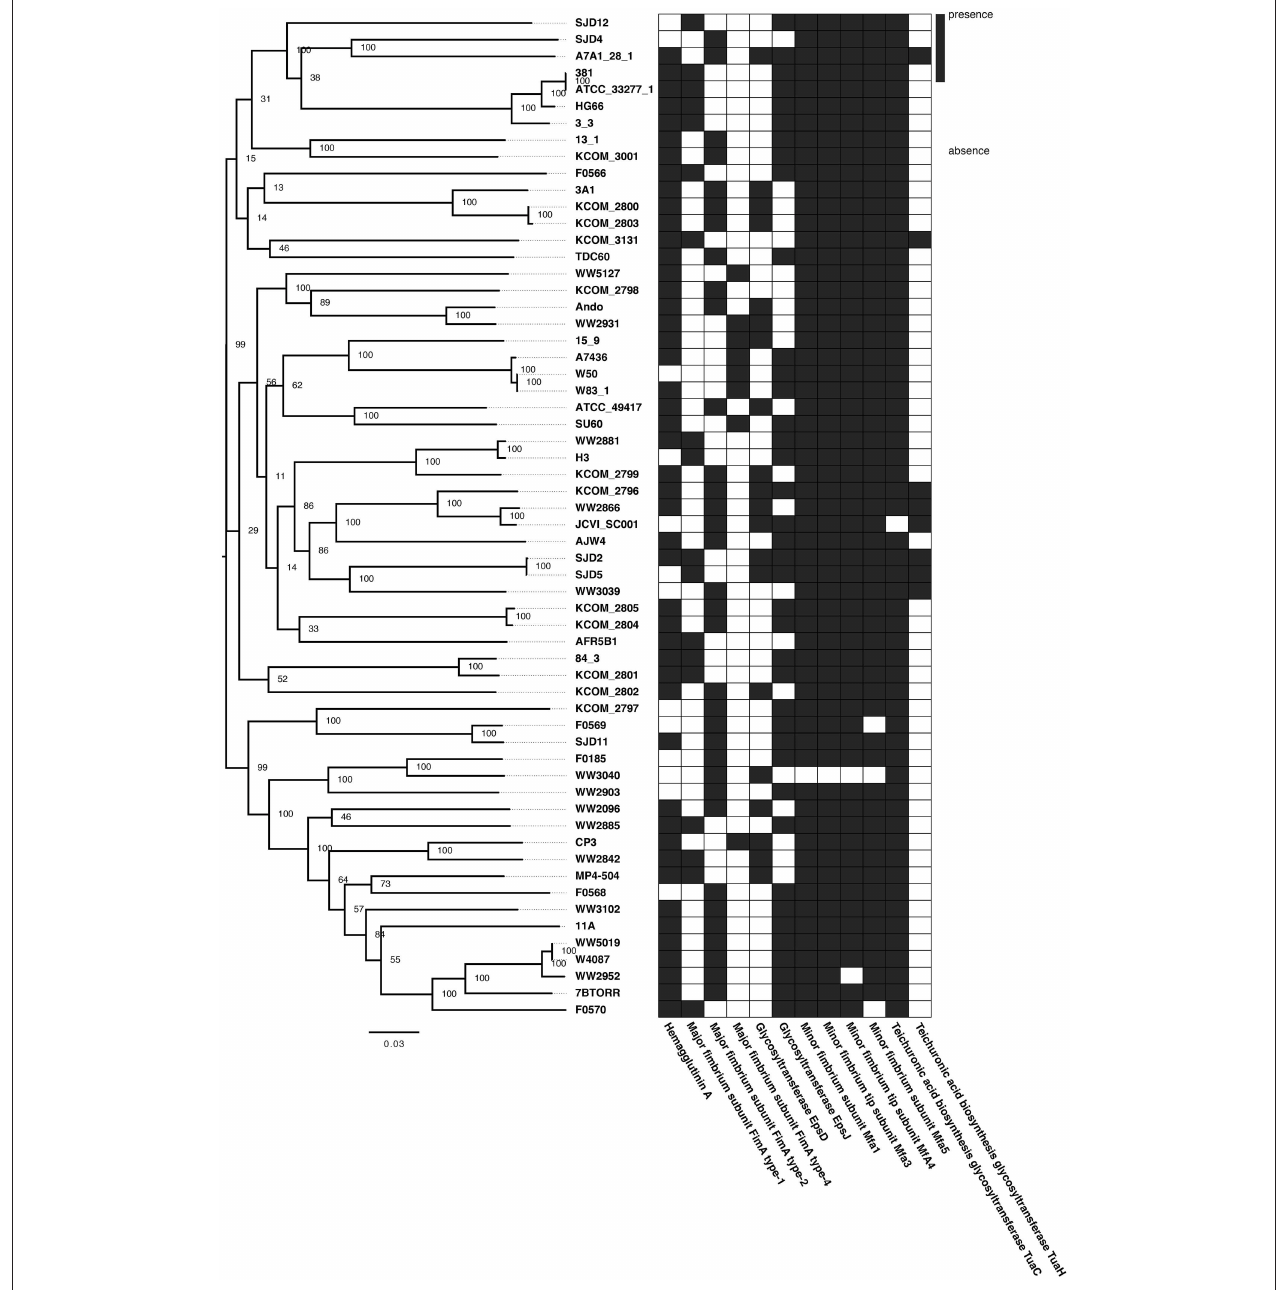
FIGURE 2 | Phylogenetic relationships among Porphyromonas gingivalis strains and presence/absence of virulence genes. (Left) Maximum likelihood tree inferred from a core SNPs alignment (16,645 polymorphic positions) of the 64-genome P. gingivalis dataset. Node labels represent the bootstrap support values. (Right) Heatmap showing the presence (black) or absence (white) of virulence genes in each P. gingivalis genome (only virulence genes belonging to the accessory genome are